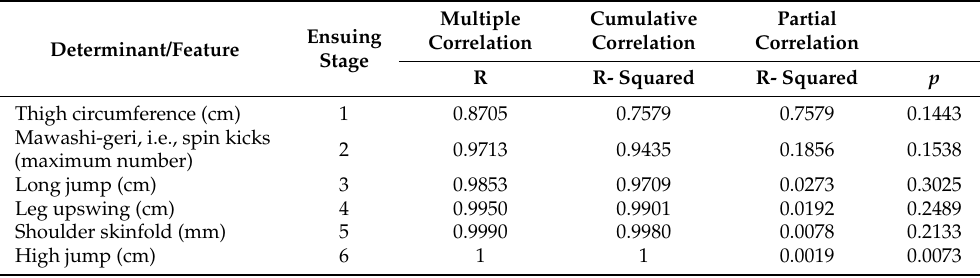
Table 3. Summary regression details from the 2nd study stage for female participants; dependent variable = ranking points.